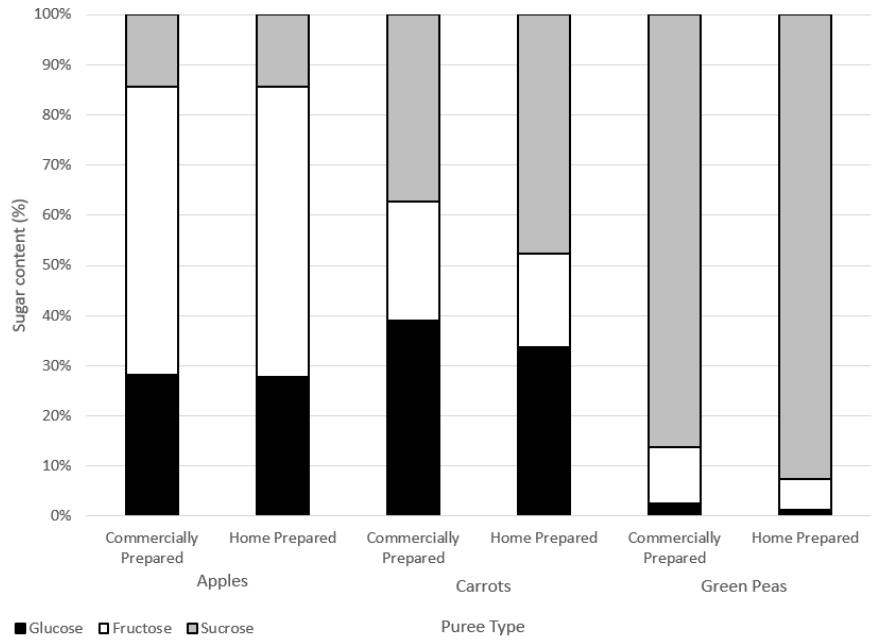
Figure 4. Sugars contents (%) of water-soluble extracts.